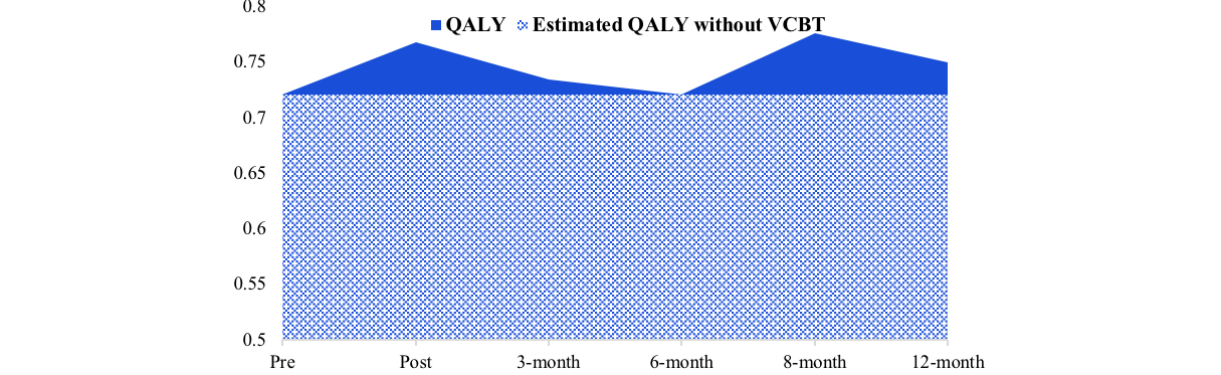
Figure 3. The quality-adjusted life years (QALYs) observed at follow-up and QALY in complete cases. Note: Estimated QALYs was calculated in terms of effective value without videoconference-delivered cognitive behavioral therapy at each time point as a baseline, with the area under the curve assuming no change. Increased QALY was calculated as the difference between the measured utility value and the estimated QALY.